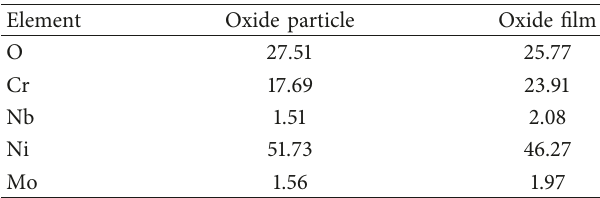
Table 1: EDS of oxide particles and oxide films after immersion for 500h.